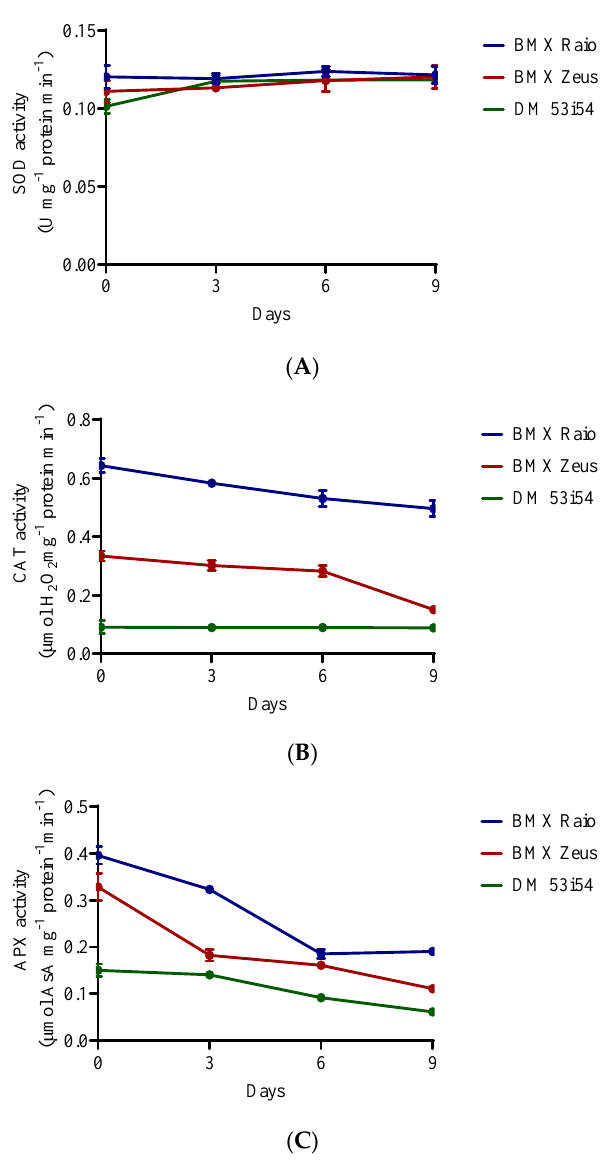
Figure 2. Enzymatic activity of superoxide dismutase (SOD) ( A ), catalase (CAT) ( B ), and ascorbate peroxidase (APX) ( C ) of soybean seed embryonic axis of three cultivars (BMX Raio, BMX Zeus, and DM 53i54) exposed to different periods of accelerated aging (0, 3, 6, and 9 days).